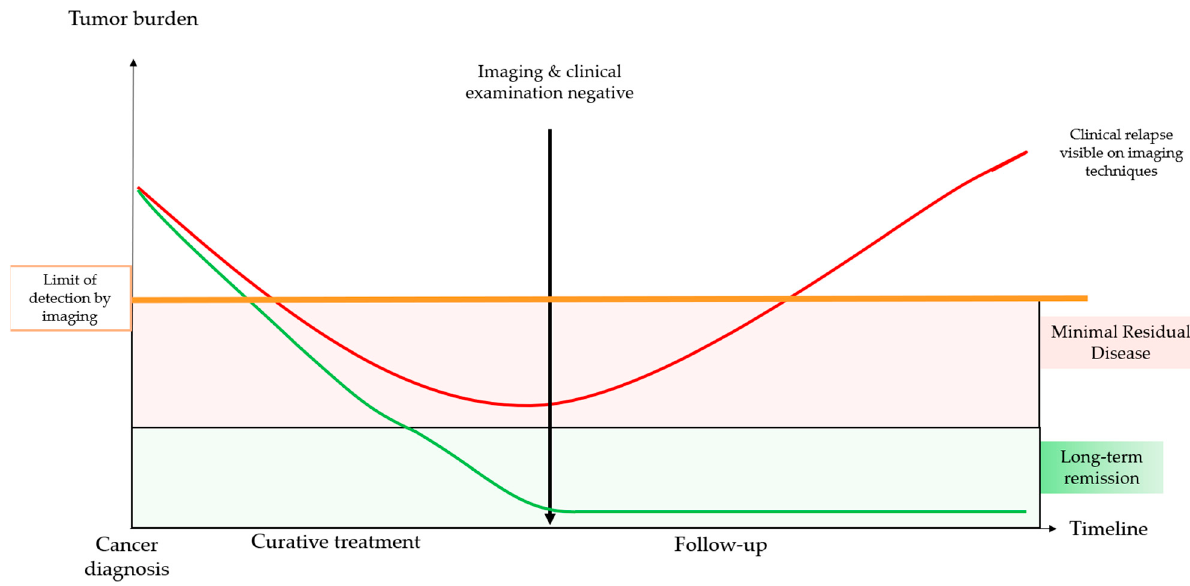
Figure 1. Schematic view of minimal residual disease (MRD).